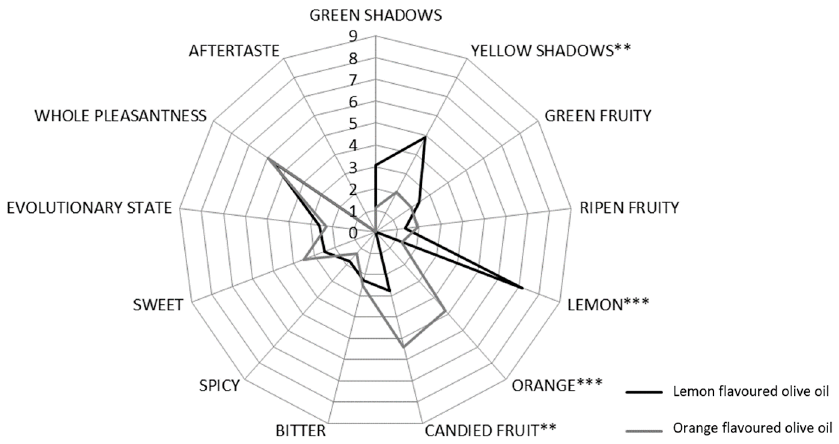
Figure 1. Sensory profile of Citrus Olive Oils. Stars meant differences statistically significant (***: p < 0.001;